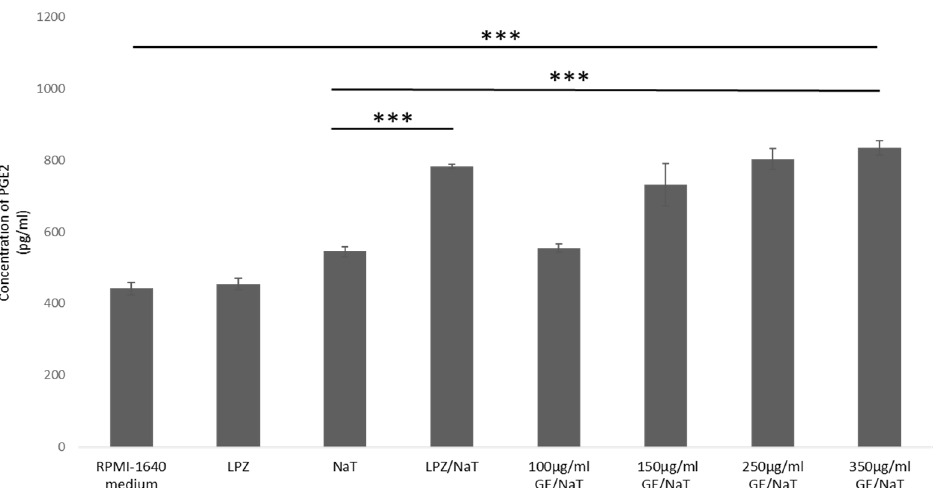
Figure 4. Effects of GE pretreatment on the levels of PGE2 in AGS cell line. PGE2 measurements were carried out by spectrophotometry at 450 nm. One way ANOVA F(7,23) = 187.1; p = 3.98 × 10 − 14 ; post hoc Tukey HSD. The values are represented in picograms per milliliter as average with standard deviation ± SD. Bars assigned with asterisks are statistically significantly different (*** p < 0.001) The data shown are representative of at least three independent experiments. Prostaglandin E2 (PGE2), human gastric cell line (AGS), sodium taurocholate (NaT/4 mM), lansoprazole (LPZ/10 µM), garlic extracts (GE/100, 150, 250 and 350 µg/mL).